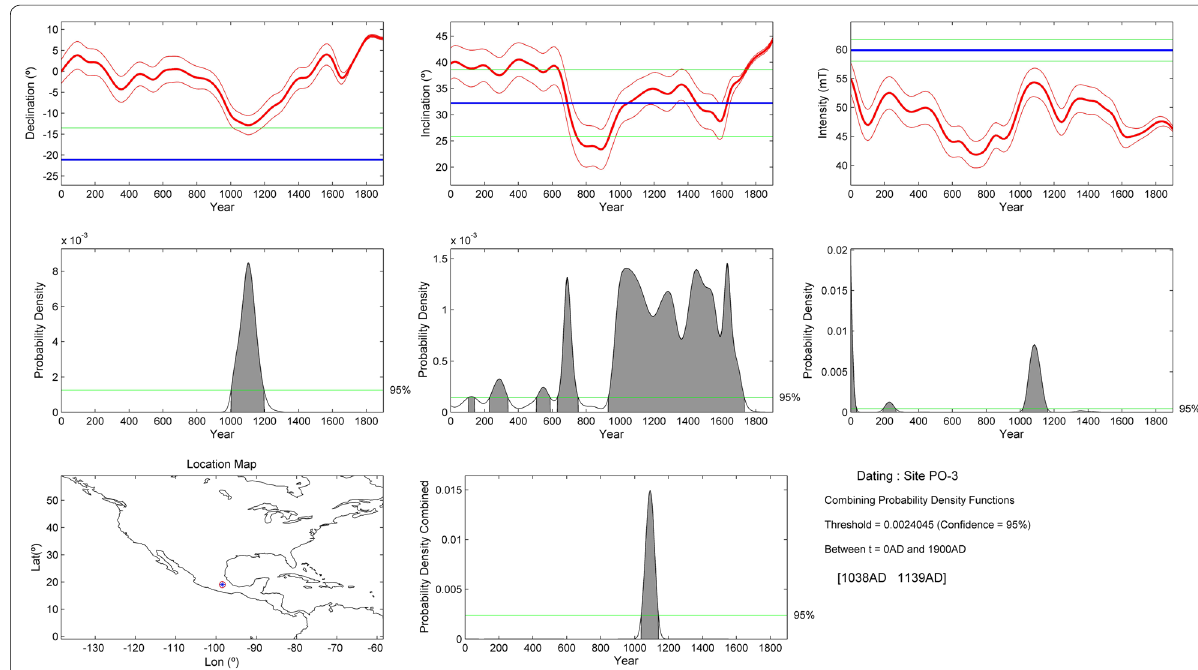
Fig. 17 Full‑vector paleomagnetic dating of the Nealtican (1 k) lava flow. Upper panels: red thick curves show the variation in time of the directional (declination and inclination) and magnitude (intensity) components of the paleomagnetic field as determined from the SHA.DIF.14 k model, while blue thick horizontal lines represent the mean declination, inclination and intensity of the ancient field determined in laboratory. All curves/lines are shown with their corresponding 95% confidence intervals (thin curves/lines above and below the corresponding thick curves/line). Central panels: The corresponding probability density functions are shown as shaded peaks, together with the 95% confidence level highlighted by horizontal green lines. The combined (Dec, Inc and intensity) probability density is shown at the lower most right